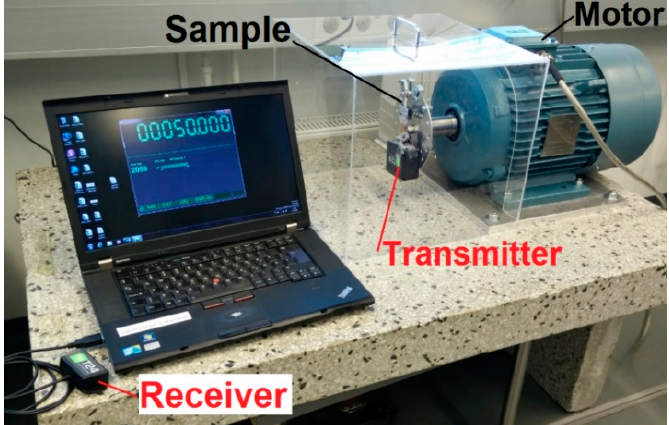
Figure 4 . Measurement setup.